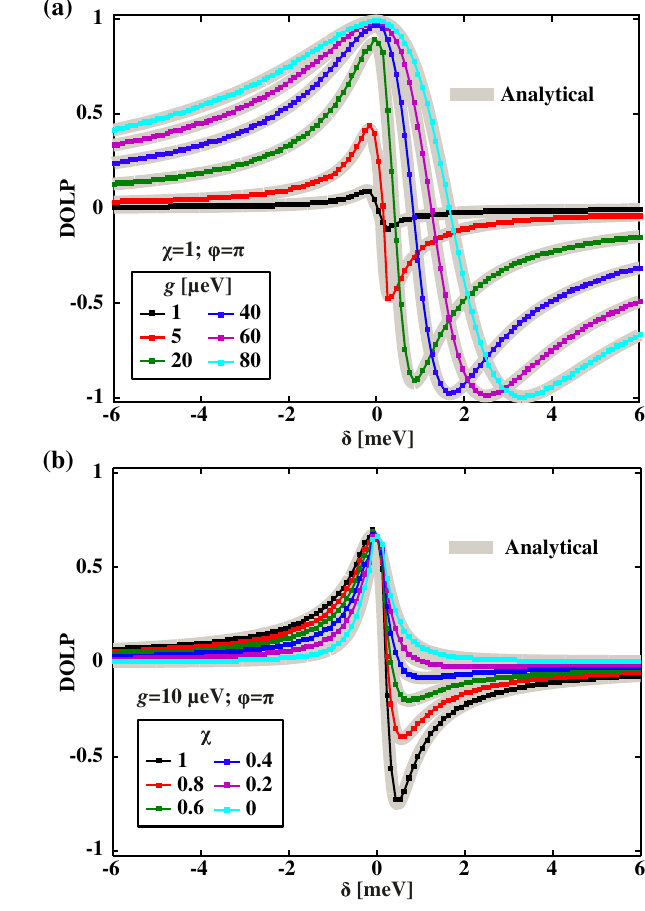
FIG. 19. DOLP spectra for different values of the X -CM coupling strength g (a) and different overlap factors χ (b). The grayed lines were calculated analytically (see Appendix C FIG. 18. Numerically and analytically calculated DOLP spectra and the calculated extremum points ( δ , D ). DOLP modeled ext ext using different overlap χ values for g ¼ 10 μ eV (a) and g ¼ 50 μ eV (b). In (a) and (b), D and D are calculated for p ffiffiffiffiffiffiffiffiffiffiffiffiffiffiffiffiffi ext 1 ext 2 δ 2 γ 2 γ 2 = = ð δ 2 factors μ 1 ¼ j δ and μ 2 ¼ δ 2 Þ account- ext j ext þ ext ext þ d d ing for spectral diffusion (see Appendix C 2). Modeling para- 120 μ eV, emission rate meters are pure dephasing rate γ d ¼ γ ¼ 0 . 46 μ eV, CM damping rate κ ¼ 400 μ eV, and relative phase φ ¼ π .